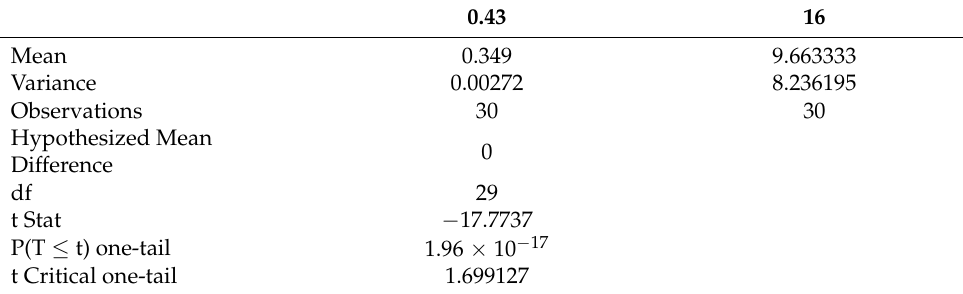
Table 5. t -test result between RFA and AI for left foot.